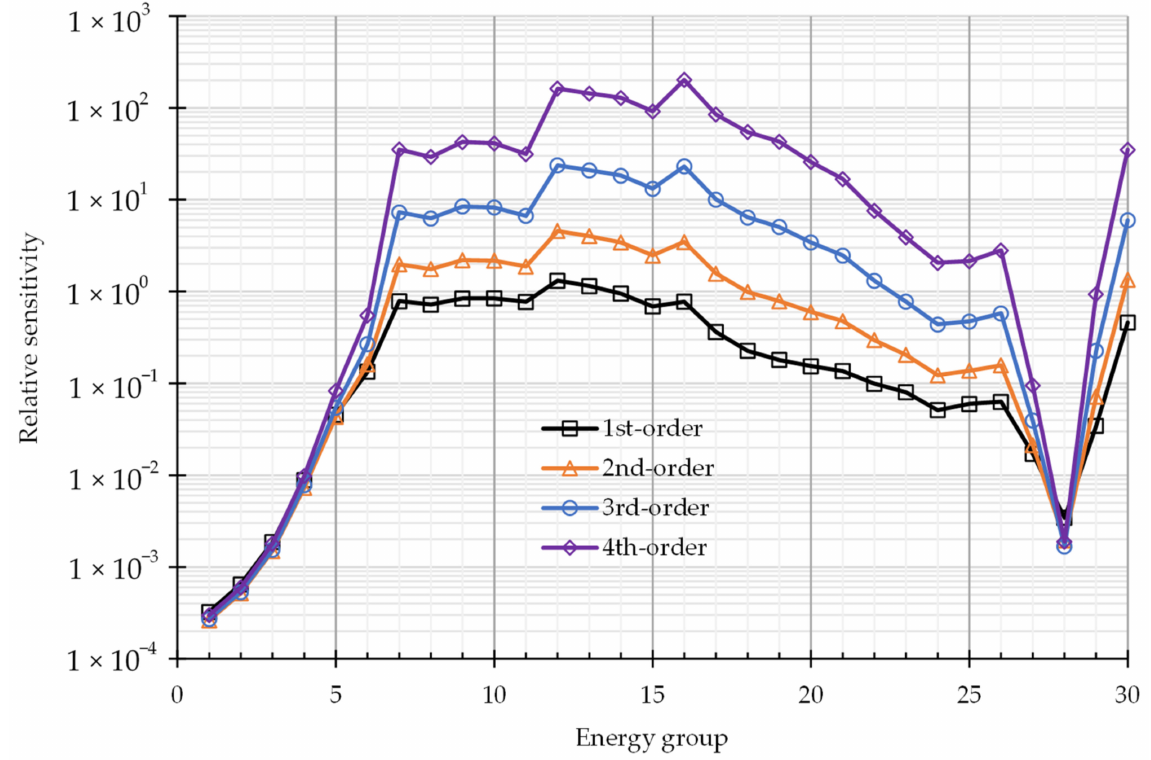
Figure 2. Illustration of the absolute values of the 1st-order through 4th-order unmixed relative sensitivities for isotope 1 ( 239 Pu) of the PERP